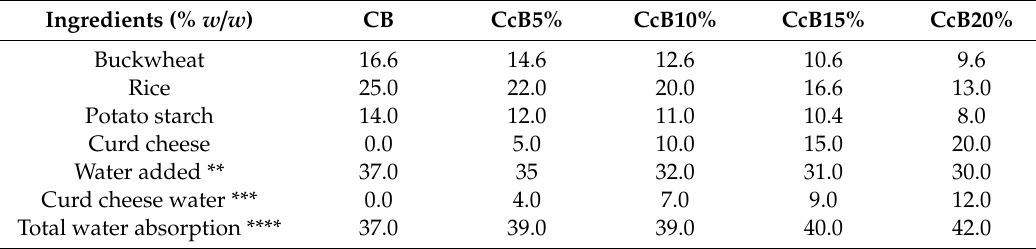
Table 1. Bread formulations tested: control bread (CB) and curd cheese breads (CcB) . Ingredients (% w / w )